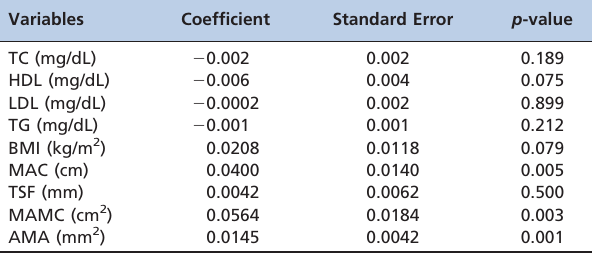
Table 2 - Multiple linear regression models for phase angle prediction, adjusted for gender and